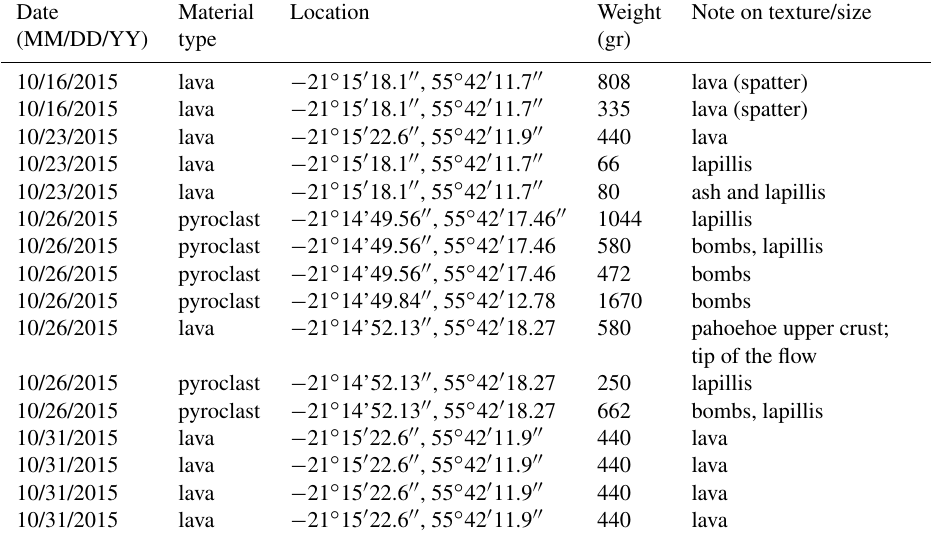
Table A1. Continued.